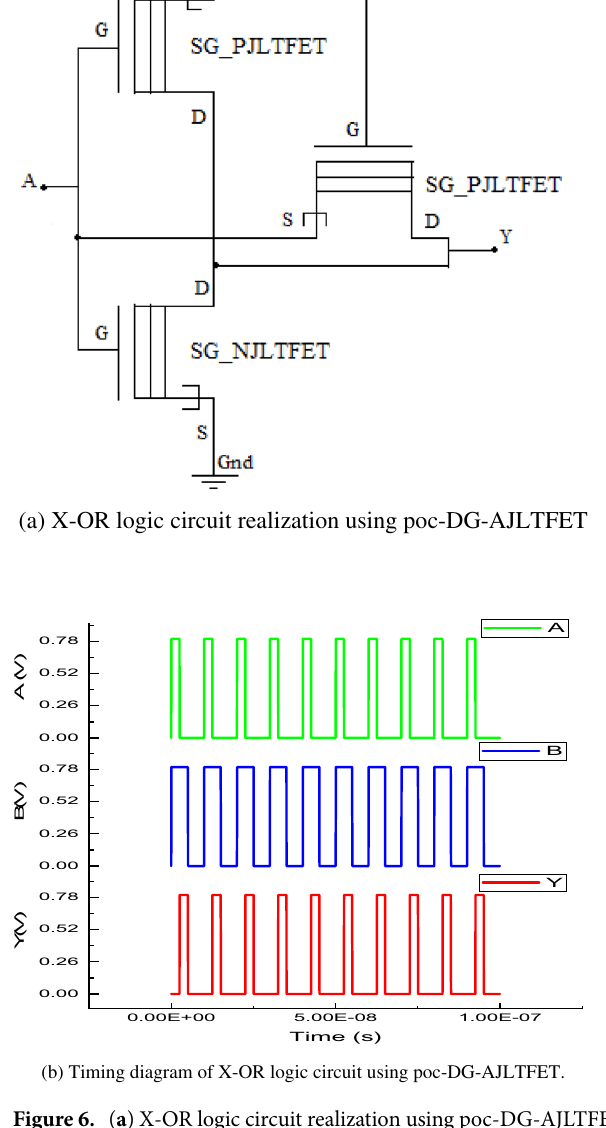
Figure 6. ( a ) X-OR logic circuit realization using poc-DG-AJLTFET. ( b ) Timing diagram of X-OR logic circuit using